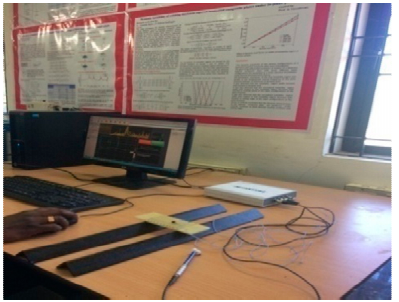
Figure 4. Experimental setup for the fundamental flexure frequency .